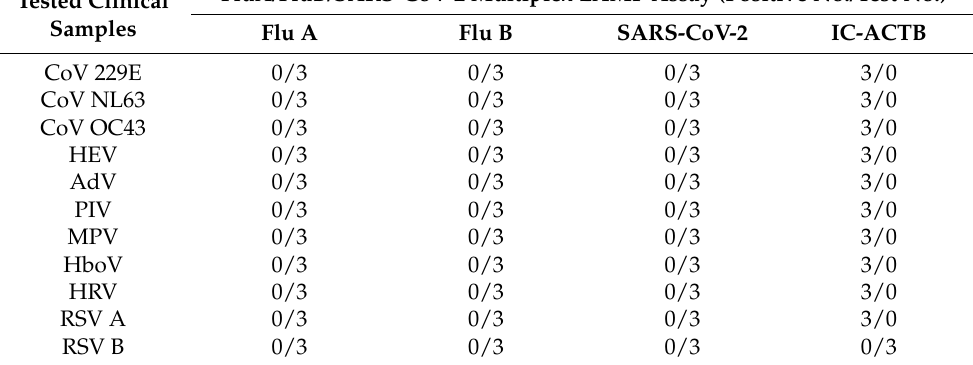
Table 7. Cross-reactivity of the FluA/FluB/SARS-CoV-2 multiplex LAMP assay against other human infectious